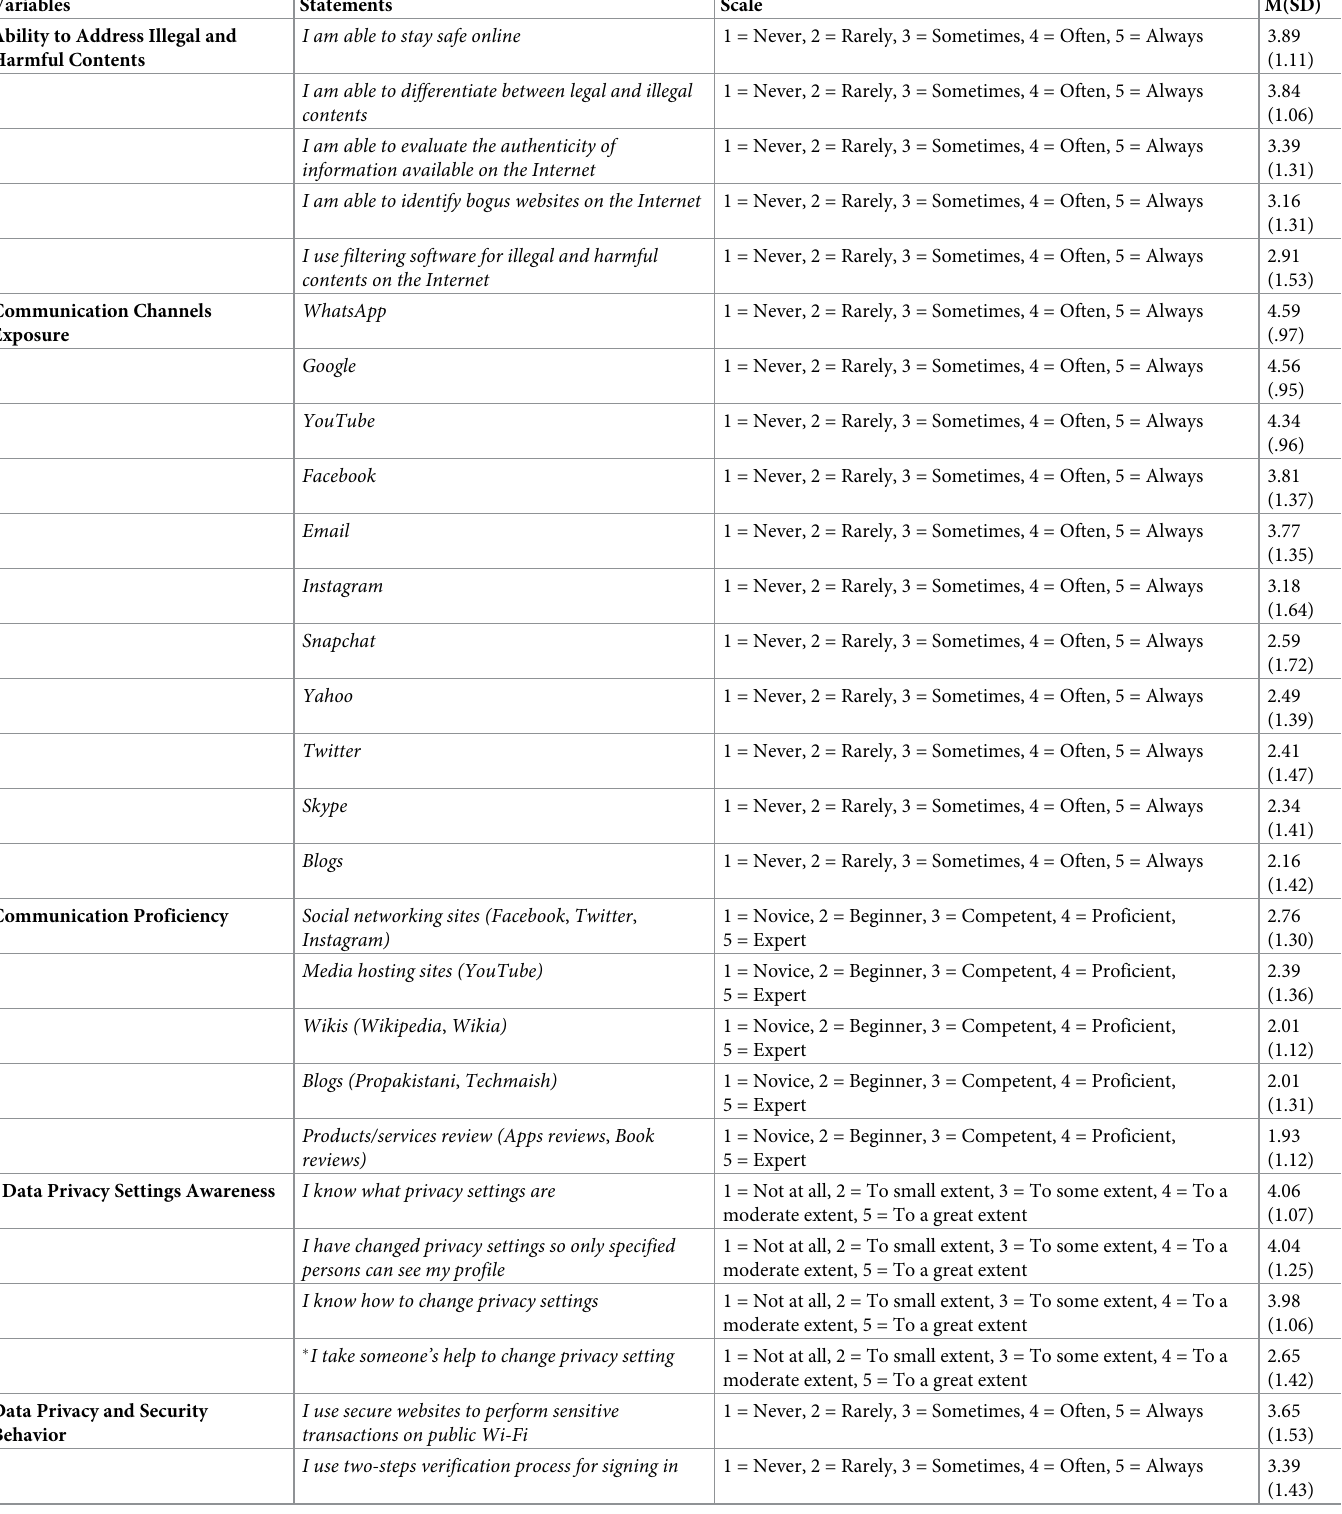
Table 3. Measurement items for the six variables of the internet literacy model.